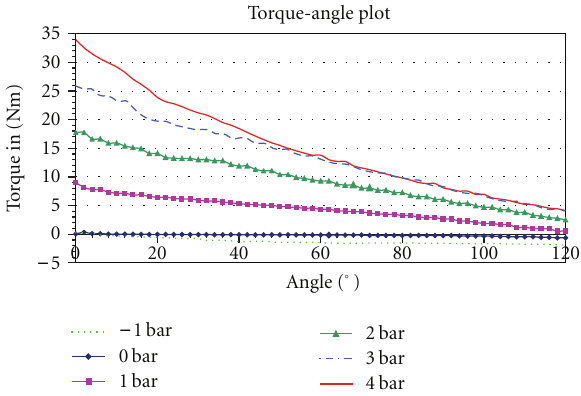
Figure 7: Torque plot of the elbow actuator.